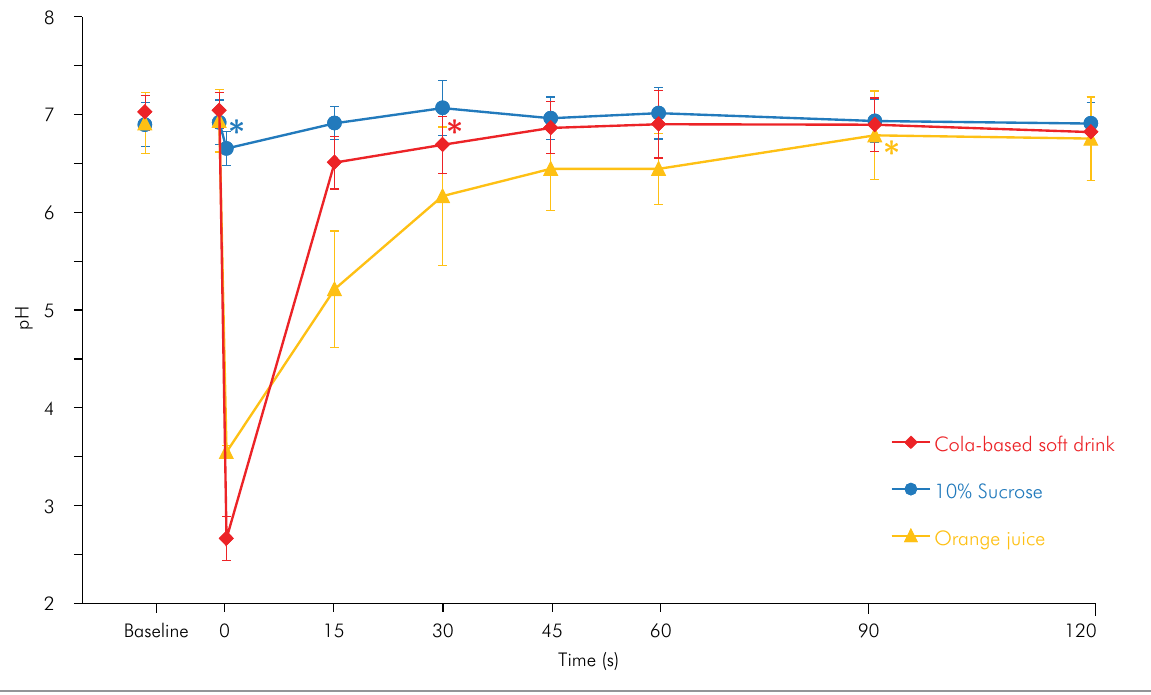
Figure 3. Saliva pH at baseline, mixed with beverage (time zero), and after expectoration of the beverage (10 to 120 s) (average ± standard deviation; n = 8). Note, for the orange juice sample at 15 s, one outlier was removed; pH = 6.6. The asterisk represents the timepoint when the pH returned to baselines values (paired t-test, p <